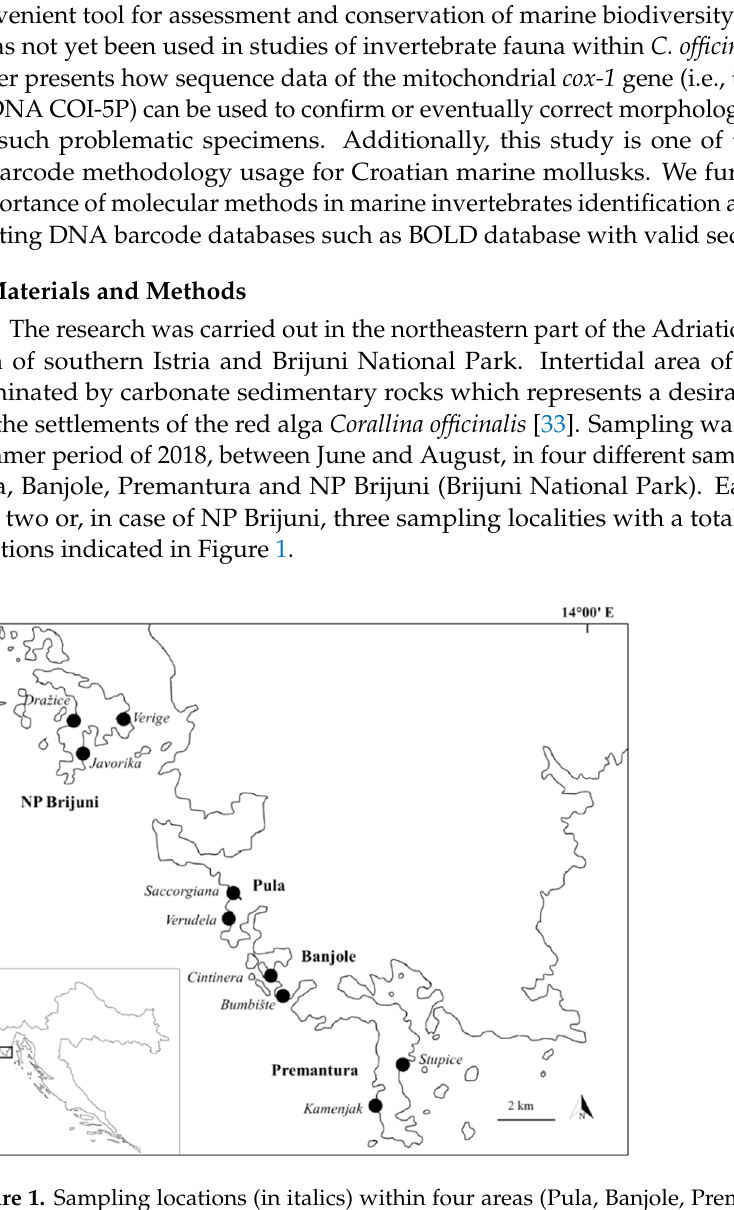
Figure 1. Sampling locations (in italics) within four areas (Pula, Banjole, Premantura, NP Brijuni) situated in southern Istria.